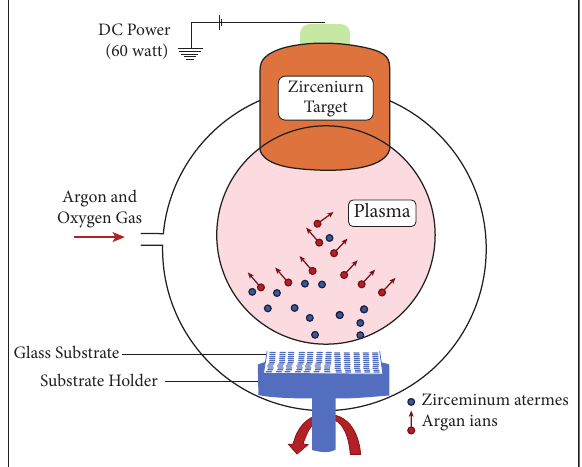
Figure 1: Schematic diagram of sputtering chamber. Table 1: Environmental parameter for ZrO